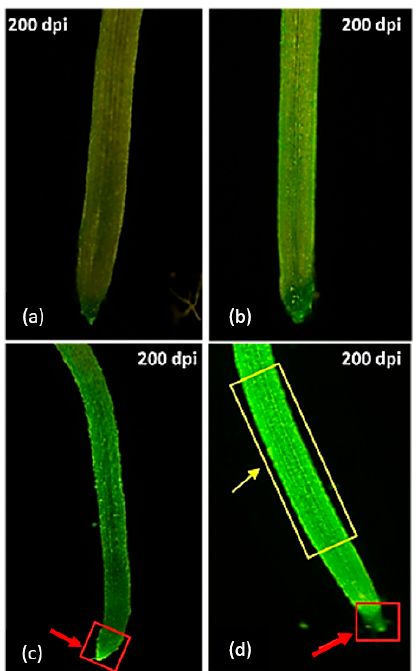
Figure 3. Calculated IC 50 for root extracts 14 DAT, demonstrating a genotype × treatment interaction ( p = 0.0001). Data points within genotypes and treatment having the same letter are not significantly different at the 95% level of confidence.